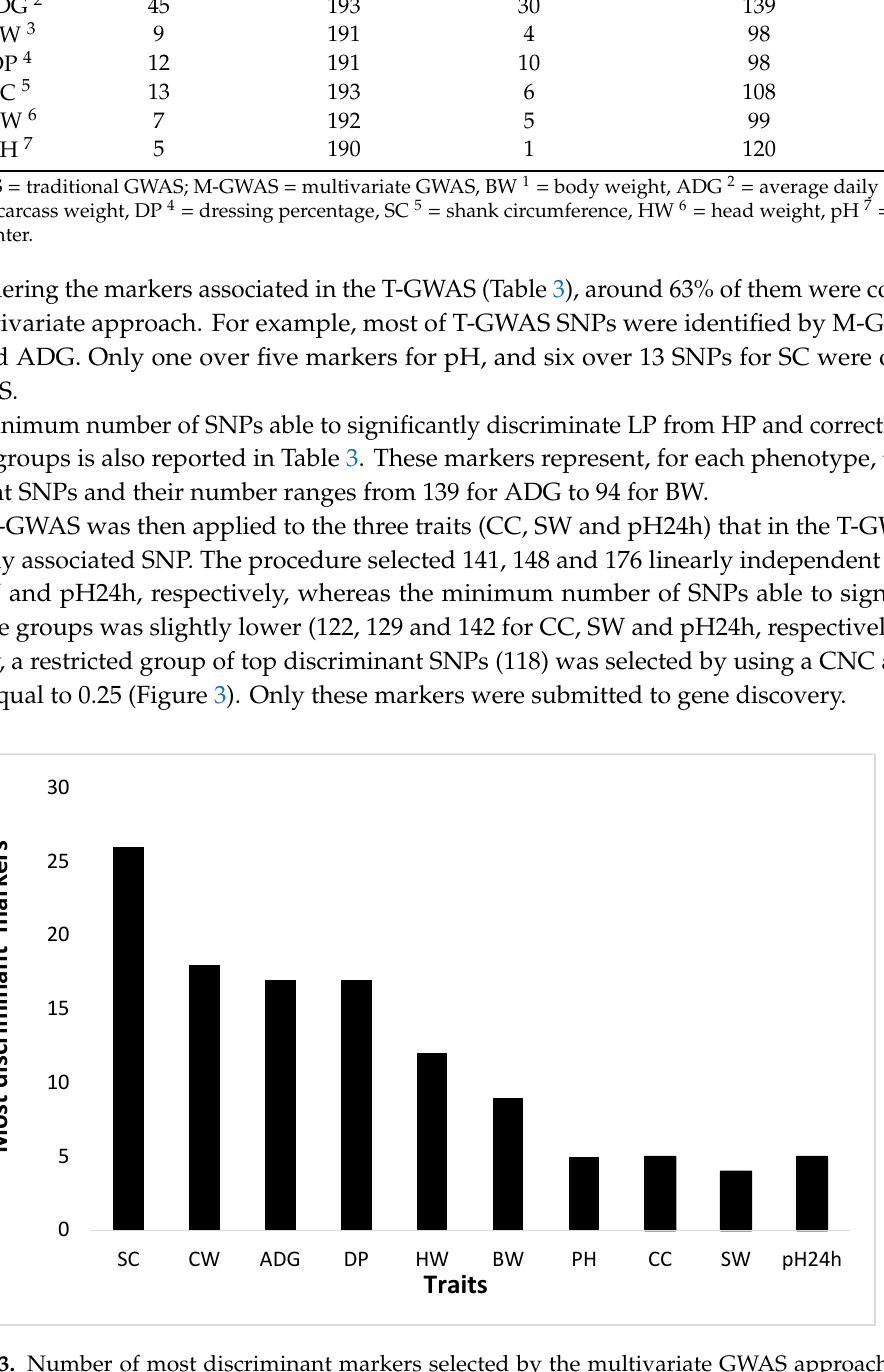
Figure 3. Number of most discriminant markers selected by the multivariate GWAS approach for the 10 traits under study. BW = body weight, ADG = average daily gain, CW = carcass weight, DP = dressing percentage, SC = shank circumference, HW = head weight, pH = pH at slaughter, CC = carcass conformation, SW = skin weight, pH24h = pH 24 h after slaughter.